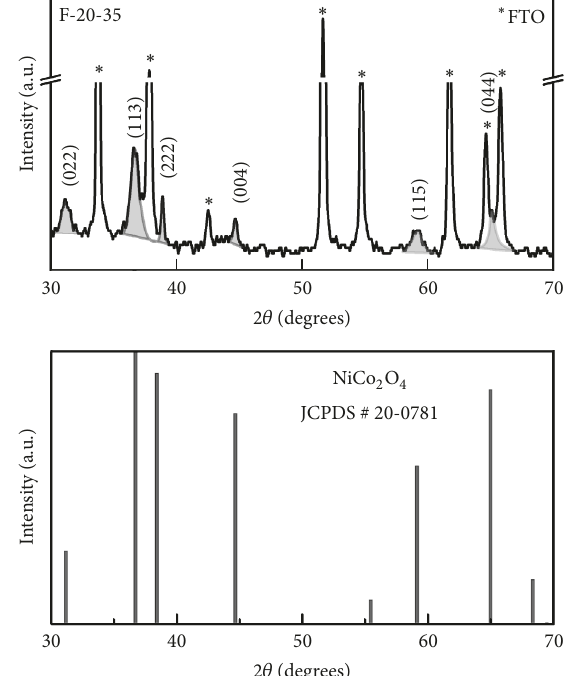
Figure 5: XRD pattern of a NiCo 2 O 4 film (sample F-20-35) after annealing at 500 ∘ C for 1 hour. The reflections marked with asterisk correspond to the fluorine-doped tin oxide (FTO) substrate; the line pattern corresponds to the reference JCPDS #